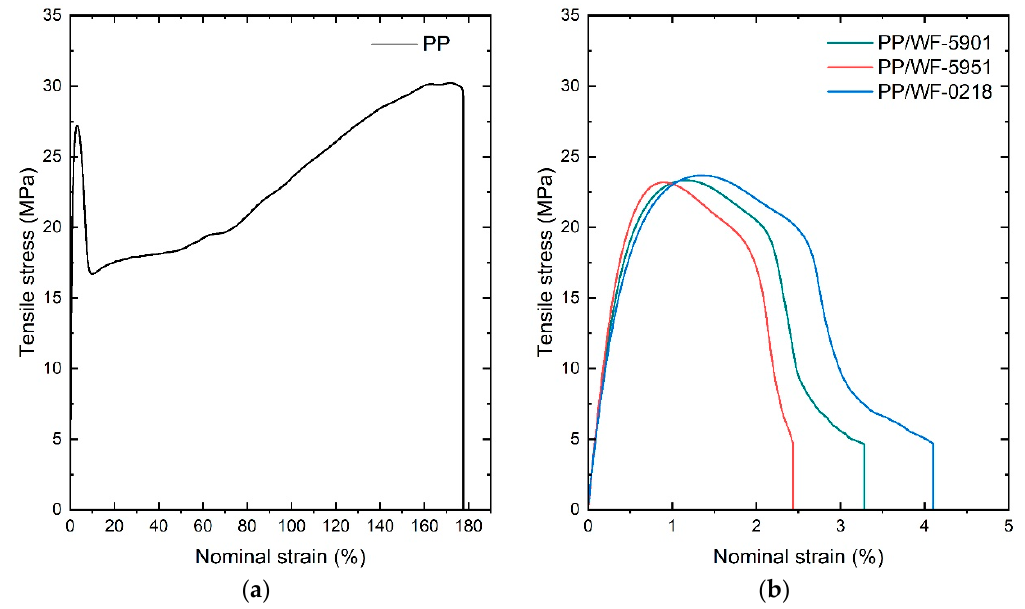
Figure 2. Stress–strain curves corresponding to ( a ) neat PP and ( b ) PP/WF